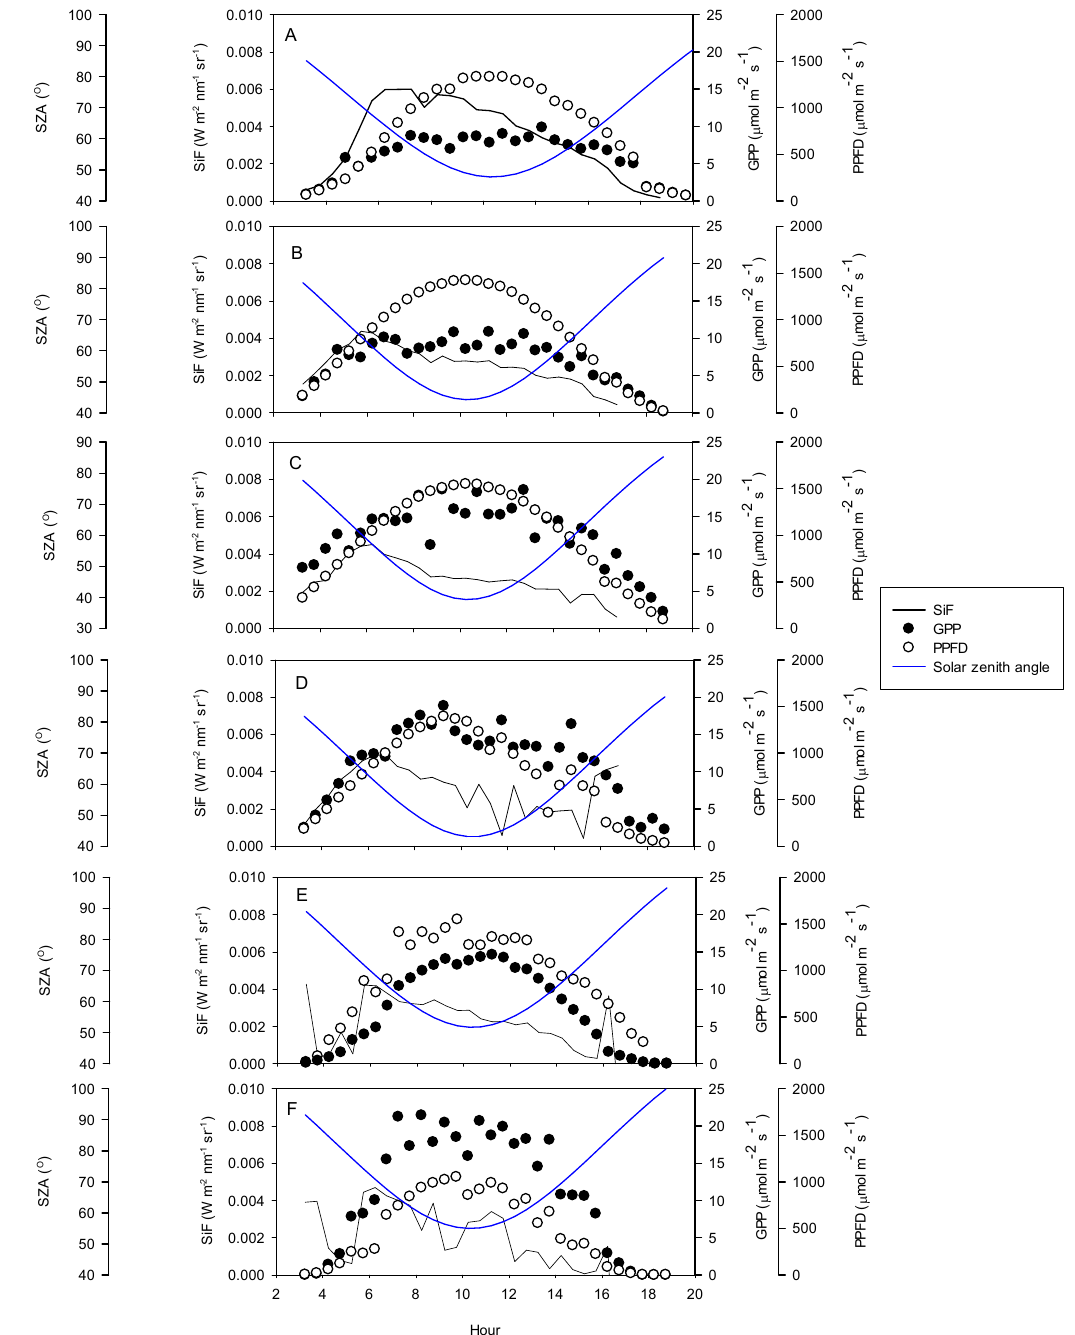
Figure 7. Diurnal relationship in SiF (-), GPP (solid circles), PPFD (open circles) and SZA (-) on select clear days throughout the growing season. ( A ) April 28th, ( B ) May 10th, ( C ) June 5th, ( D ) July 29th, ( E ) August 27th, and ( F ) September 5th.